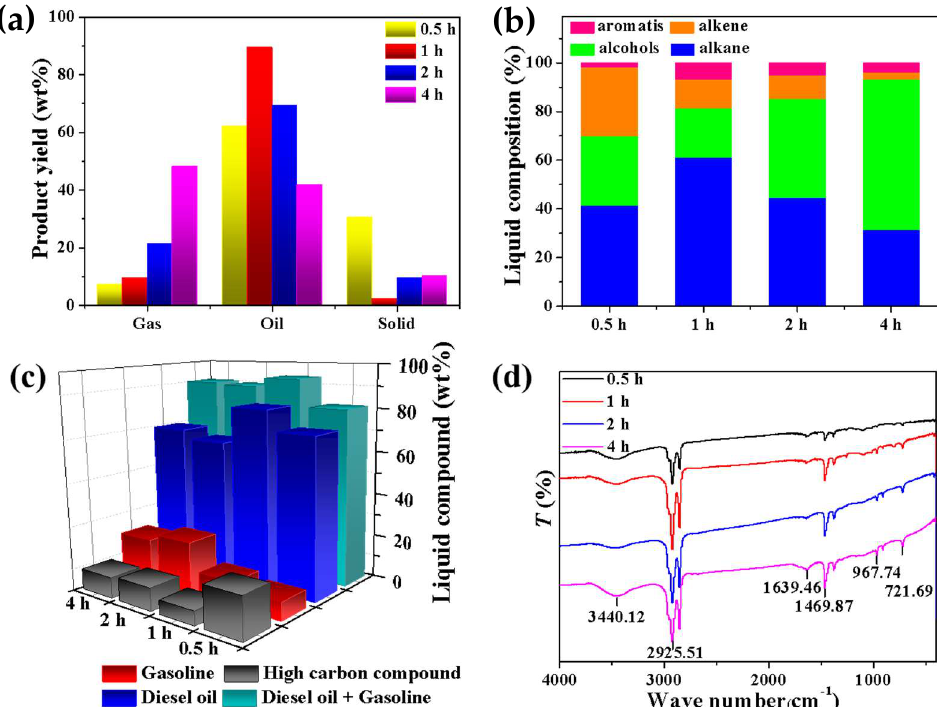
Figure 6. Product tests of NMGM thermal catalytic cracking of waste LDPE at 400 °C after different reaction times: ( a ) yield, ( b ) hydrocarbon‒composition distribution of liquid products, ( c ) liquid product‒composition distribution, ( d ) FTIR test.